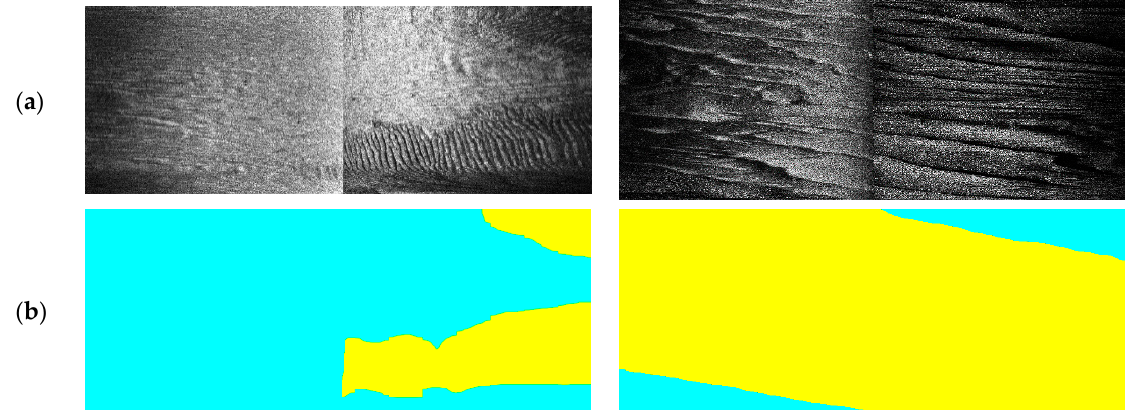
Figure 8. Example SSS annotation. ( a ) Example SSS imaging. ( b ) Labeling. We retrieved the echo intensity in each ping and then divided these into overlapping sub-sequences with the basic length of 600. Considering the operating range of 200 m per side, we made an initial estimation to cover the seabed 25 m for each sub-sequence. In total, 327,280 echo intensity sub-sequences were chosen for OS-ELM learning and statistical analysis, with 156,306 samples labeled in the category of sand waves, and 170,974 samples in the class without sand waves. For each class, we set aside one fifth for test and verification, respectively, and the rest for training. Figure 9 lists the example echo intensity sub-sequence extraction process from raw SSS imaging, with the centered red line indicating the extraction localization of echo intensity sub-sequence from raw SSS imaging patches.